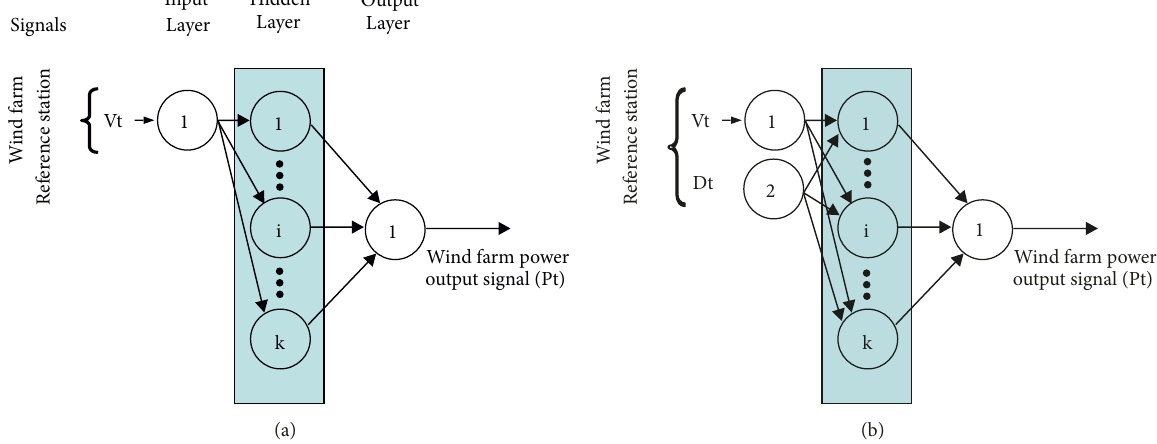
Figure 6: Schematic representation of the ANNs of the ADWFPC model when only wind speed is used in the input layer (option (a)) vs. when wind speed and direction are used (option